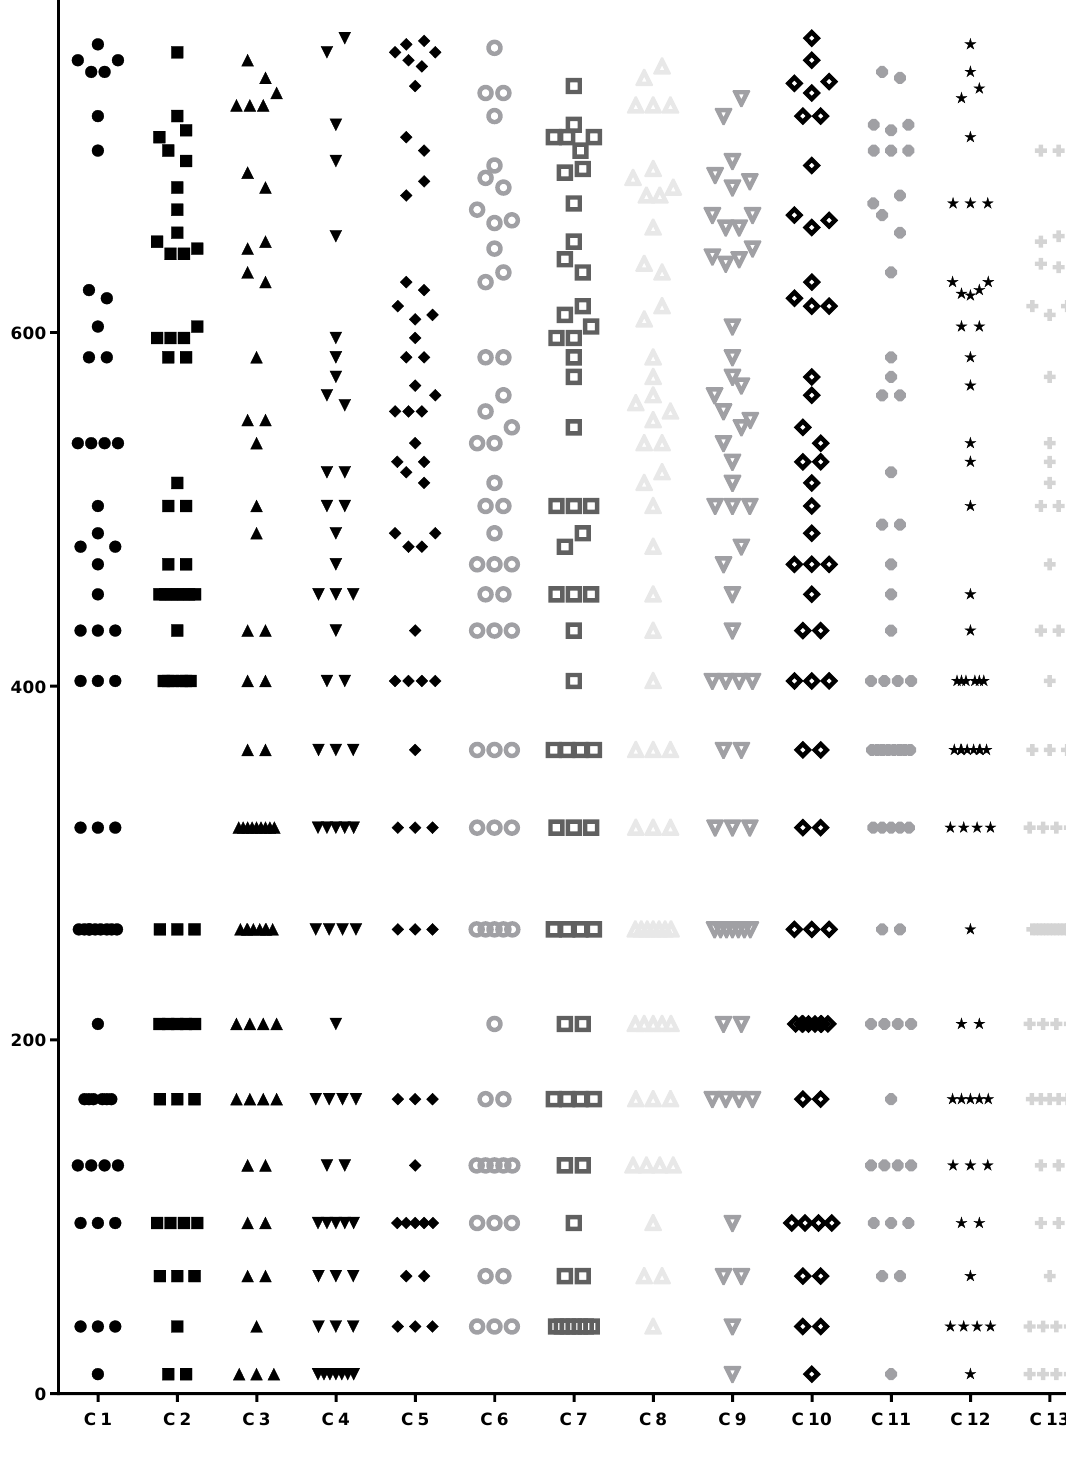
Figure 4. Kruskal-Wallis test (p < 0.05) showing ranking distribution for all use points of water distribution system The correlation matrix between different segments of the municipal water distribution system is shown in Figure 5 [16]. It could be noted that a low correlation level existed between the point-of-use ports with moderate records that were observed at the best